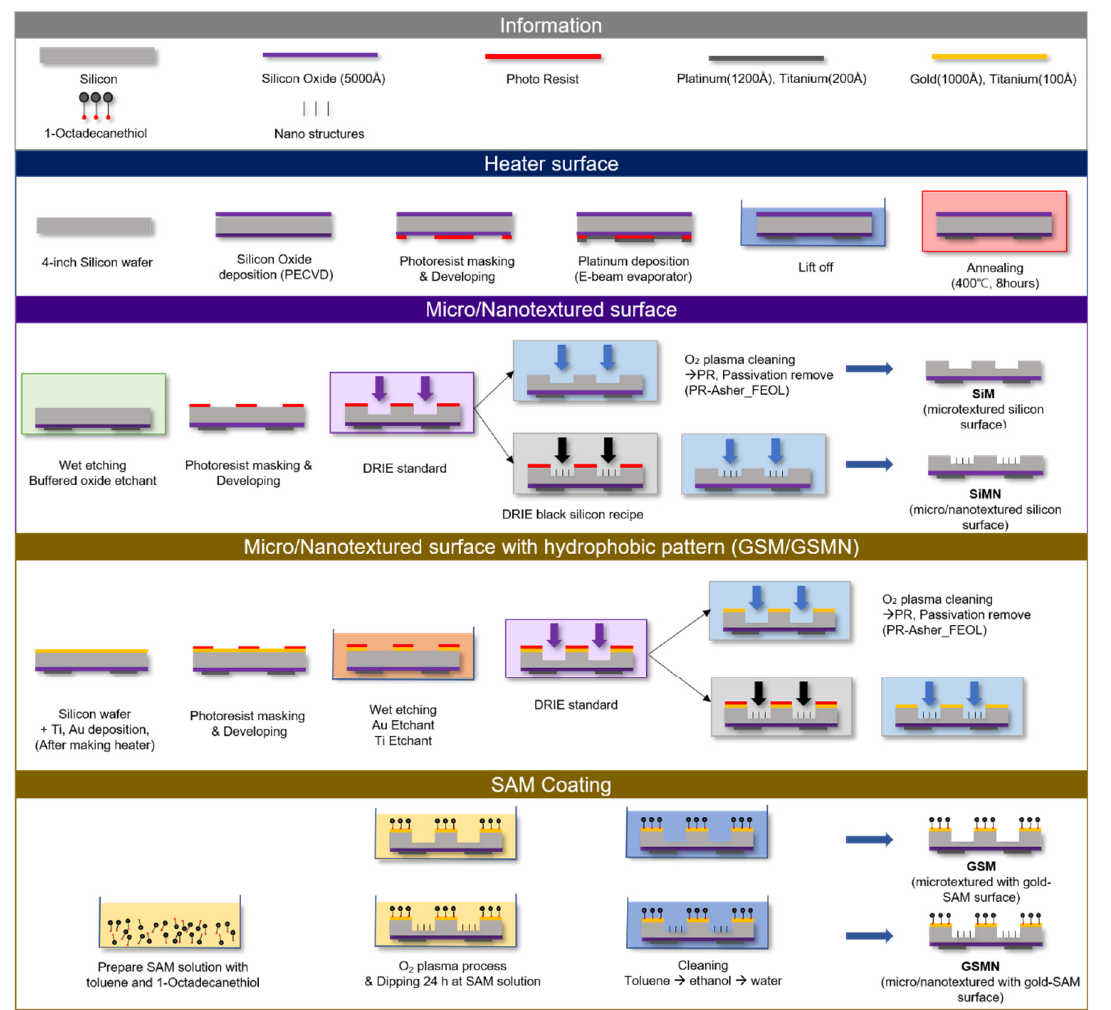
Figure 1. The method of fabrication for the test samples. First, the heater surface was fabricated and the textures were fabricated on the opposite surface of the heater.